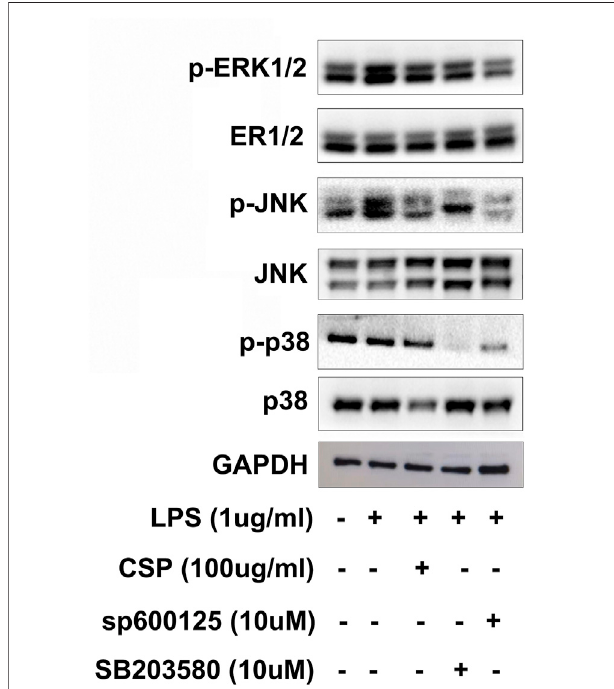
FIGURE 8 | CSP inhibited the phosphorylation of MAPKs in LPS- stimulated NR8383 cells. NR8383 cells were pretreatment with CSP (100 μ g/ ml) for 12 h, and p38 inhibitor (SB 203580, 10 µM) and JNK inhibitor (SP600125, 10 µM) for 5 h, followed by LPS stimulation (1 μ g/ml) for another 30 min. GAPDH was used as loading